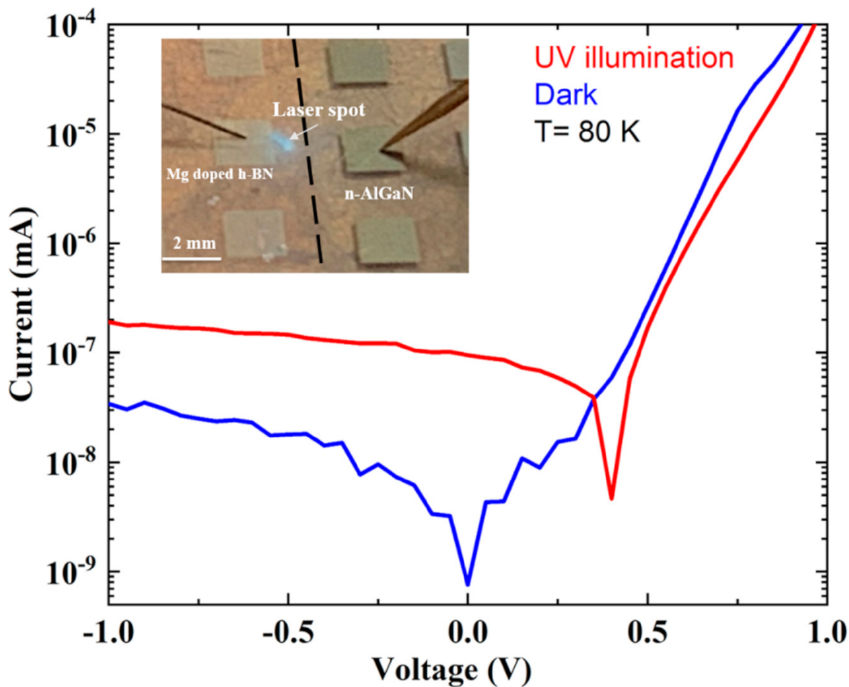
Figure 8. I–V curve recorded in Mg doped h-BN/n-Al 0.58 Ga 0.42 N (Sample F) at T = 80 K with and without UV laser illumination. The inset shows a photograph of the top view of the heterojunction with the electrical contact pad and the location of the laser